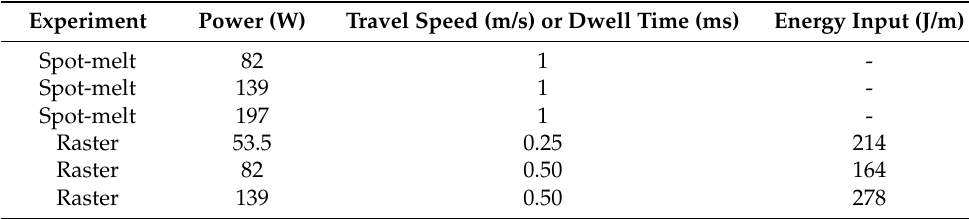
Figure 3. Dimensioned computer-aided design (CAD) model used within SYSWELD for all spot-melt and raster scenarios. Table 1. Process parameters of the modeled spot-melt and raster experiments.